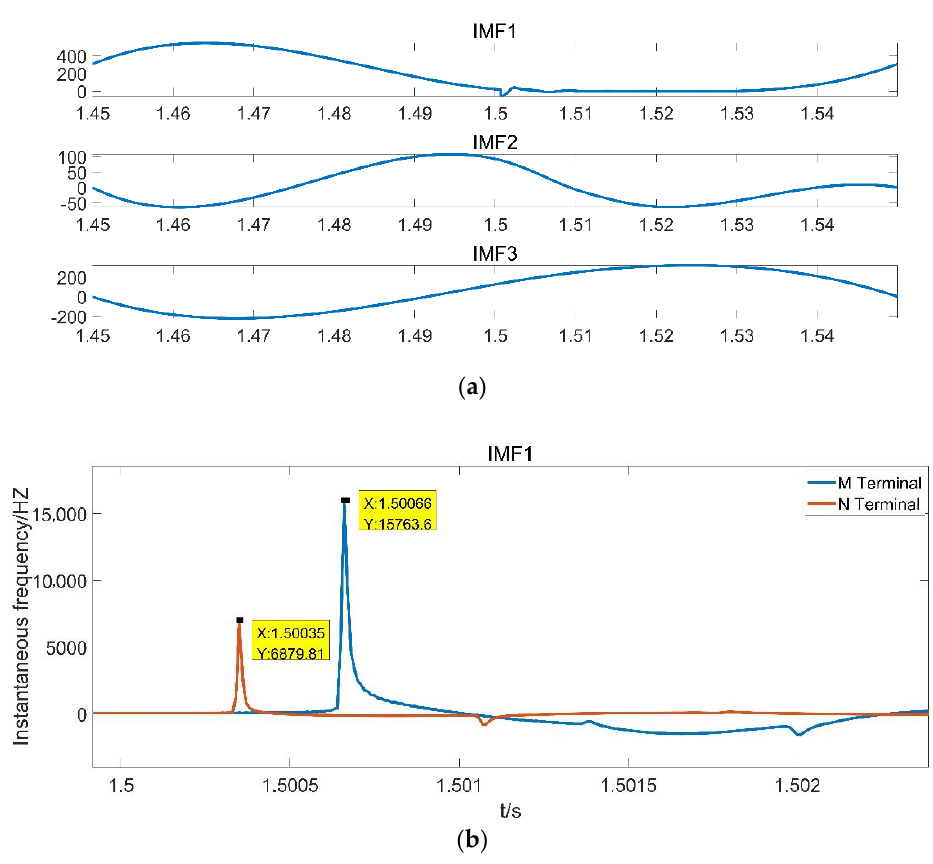
Figure 10. Using HHT to analyze faults at 130 km. ( a ) IMF component. ( b ) Instantaneous frequency curve.